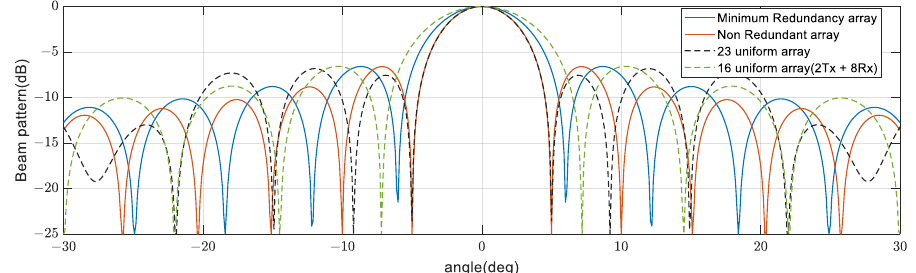
Figure 12. Comparison of beam patterns at N = 5. VAA’s beampattern by the non-redundant array shows the smallest beamwidth, but the sidelobe is similar to that by the MRA.